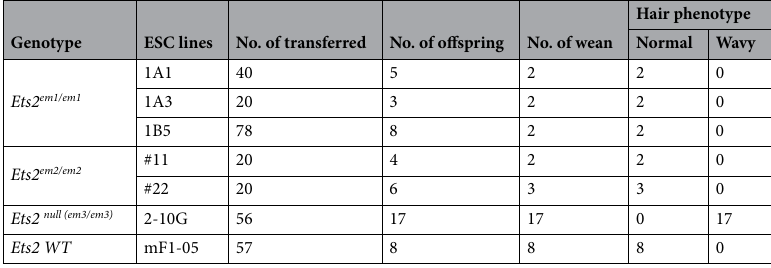
Genotype ESC lines No. of transferred No. of offspring No. of wean